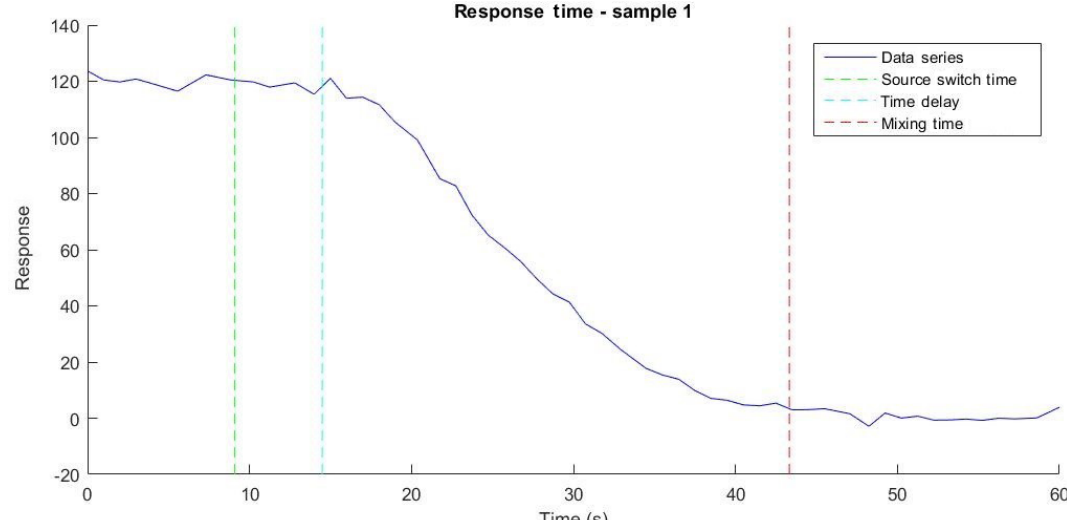
Figure 4. The fluorescence data series over time for the response time of Sample 1 with the time the source switched from cigarette smoke to nitrogen (source switch time), the time at which the fluorimeter began to measure a decrease in signal (response time delay), and the time at which the signal reduced to the background (mixing time